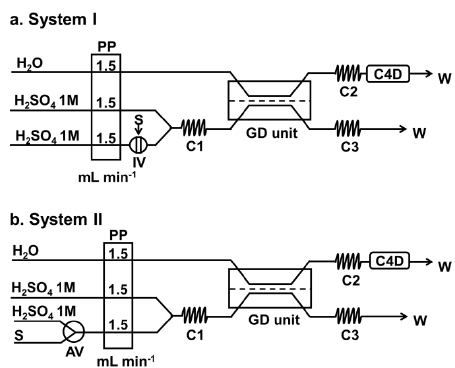
Figure 1. Schematic of the flow-injection systems with an in-line GD unit and a C4D detector. System I with injection valve (IV) is used for clear samples and for the optimization study. System II allows for aspiration of sample via the 3-way valve (AV) and is used for both clear and turbid samples. PP: peristaltic pump; IV: injection valve; AV: 3-way aquarium valve; C1 and C2: mixing coils; C3: back-pressure coil; GD: gas di ff usion unit; C4D: capacitively coupled contactless conductivity detector; S: sample; W: